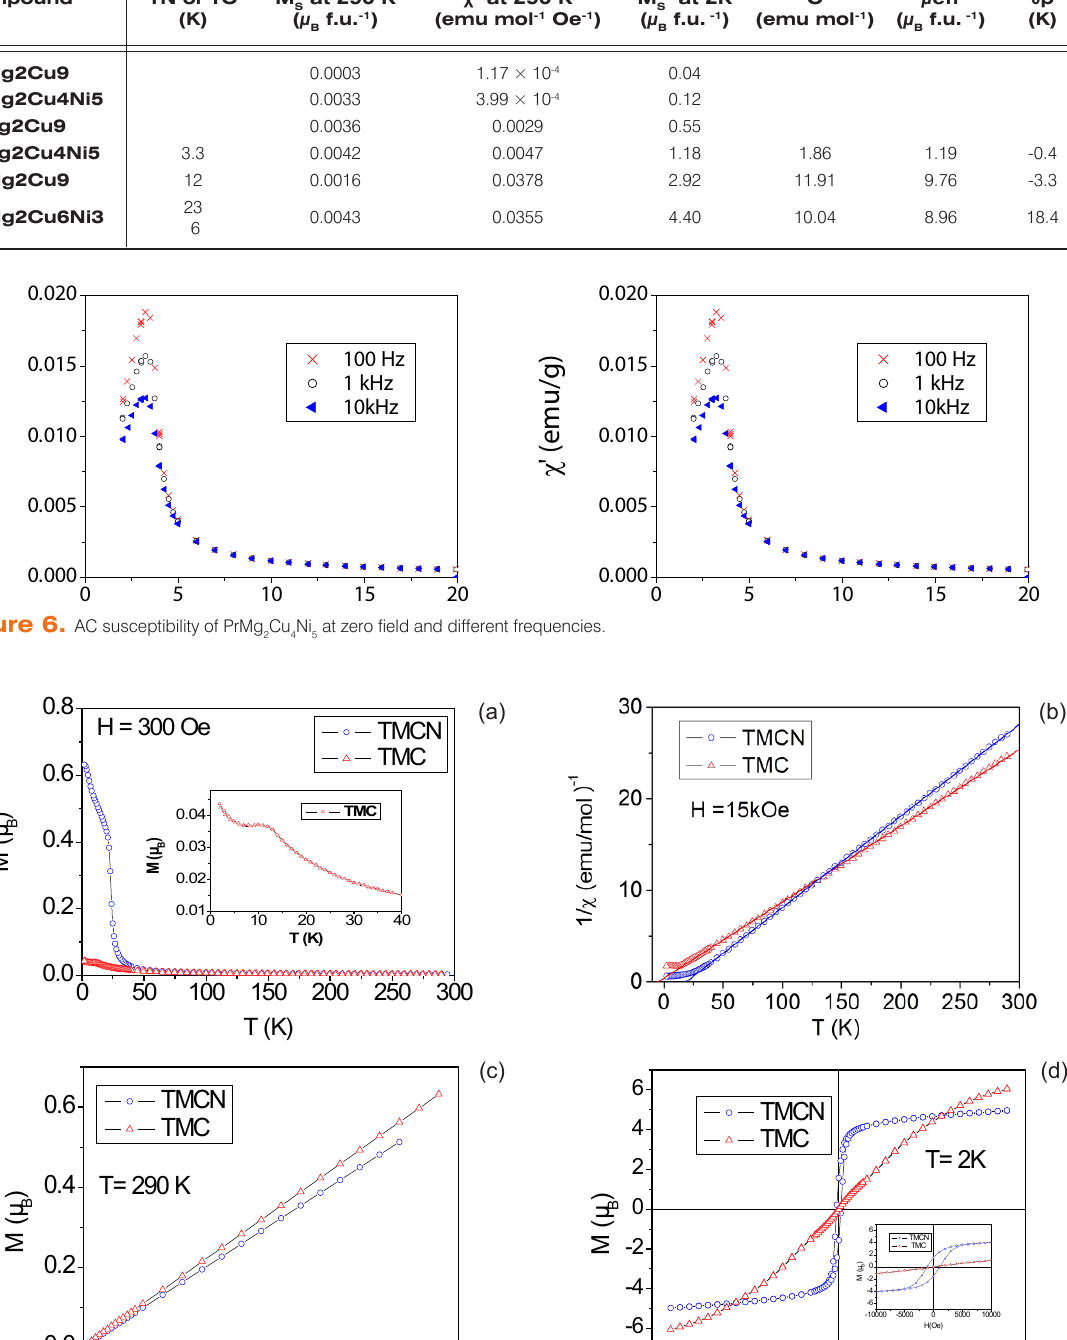
Table 5. Magnetic parameters of REMg from high field to zero field.